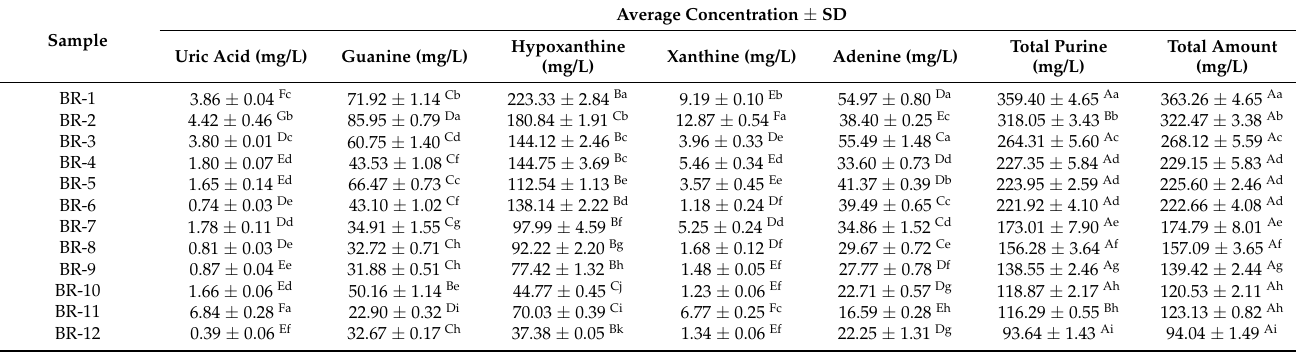
SD: standard deviation. Different capital letters in the same row indicate significant differences between the contents of different compounds in the same Chinese chicken broth ( p < 0.05), and different lowercase letters in the same column indicate significant differences between different samples of the same compound ( p <